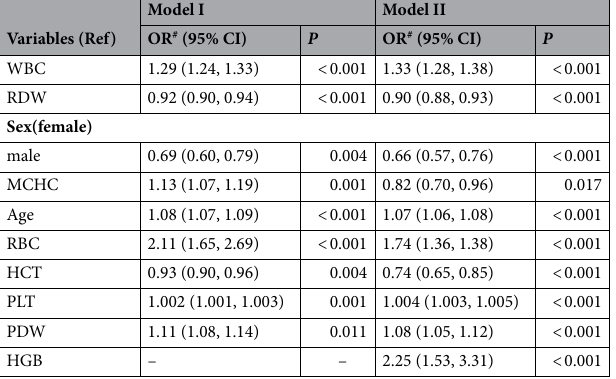
Table 2. The results of multiple LR model. # OR = odds ratio HCT Hematocrit, PLT Platelet count, RDW Red cell distribution width, PDW Platelet distribution width, RBC Red blood cell, MCHC Mean corpuscular hemoglobin concentration, WBC White blood cell, HGB